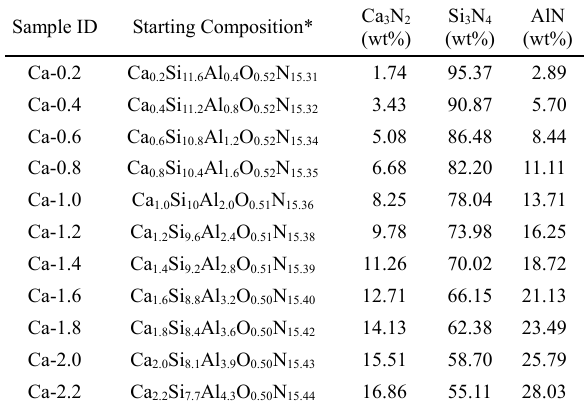
nitrogen rich sialons, along with sample ID, mole composition, and weight